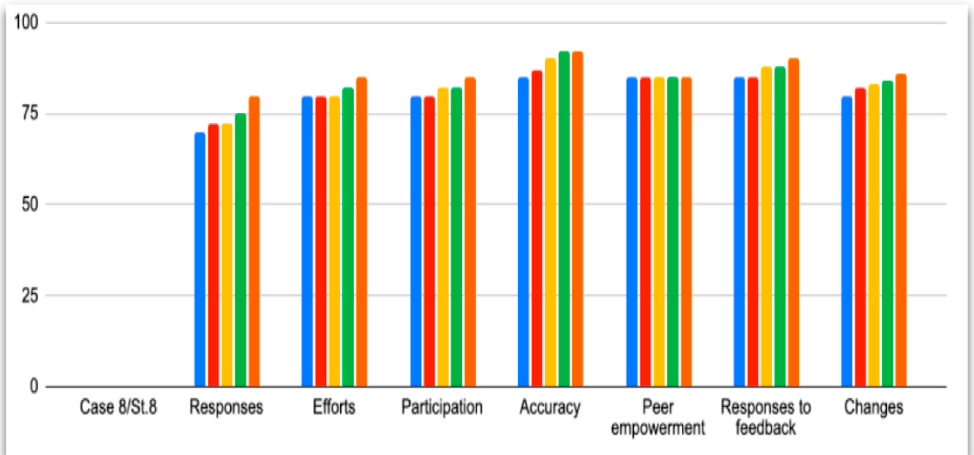
Figure 8. Vocabulary and spelling progress during alternative assessment online/Case 8.